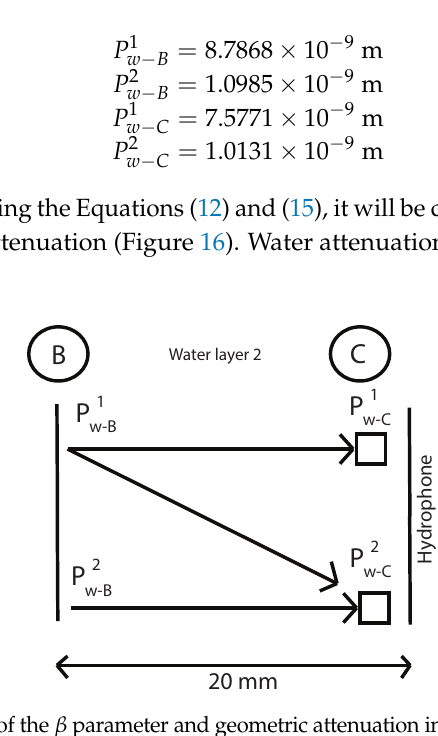
Figure 16. Determination of the β parameter and geometric attenuation in water layer 2 without specimen.